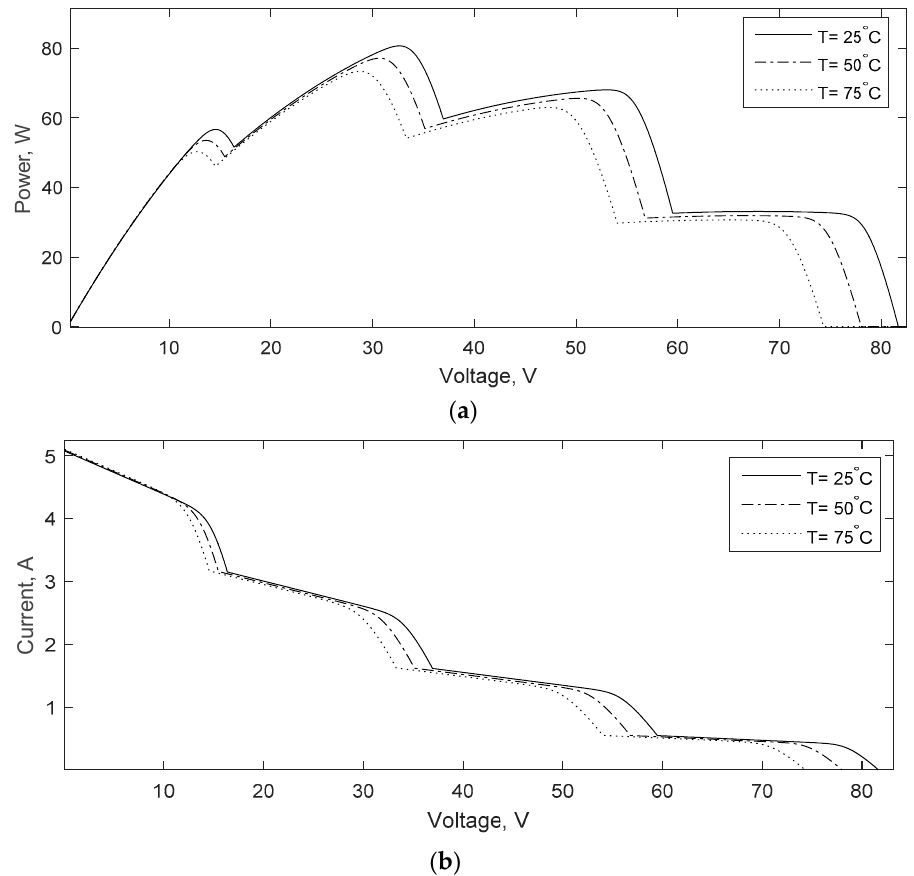
19 of 22 ( d ) Figure 15. ( a ) PV power, ( b ) PV voltage, ( c ) PV current, ( d ) Duty cycle in pattern 4 using different methods. Table 7. Numerical results of the ROA, MRFO, and PSO methods in pattern 4. Parameter/Method